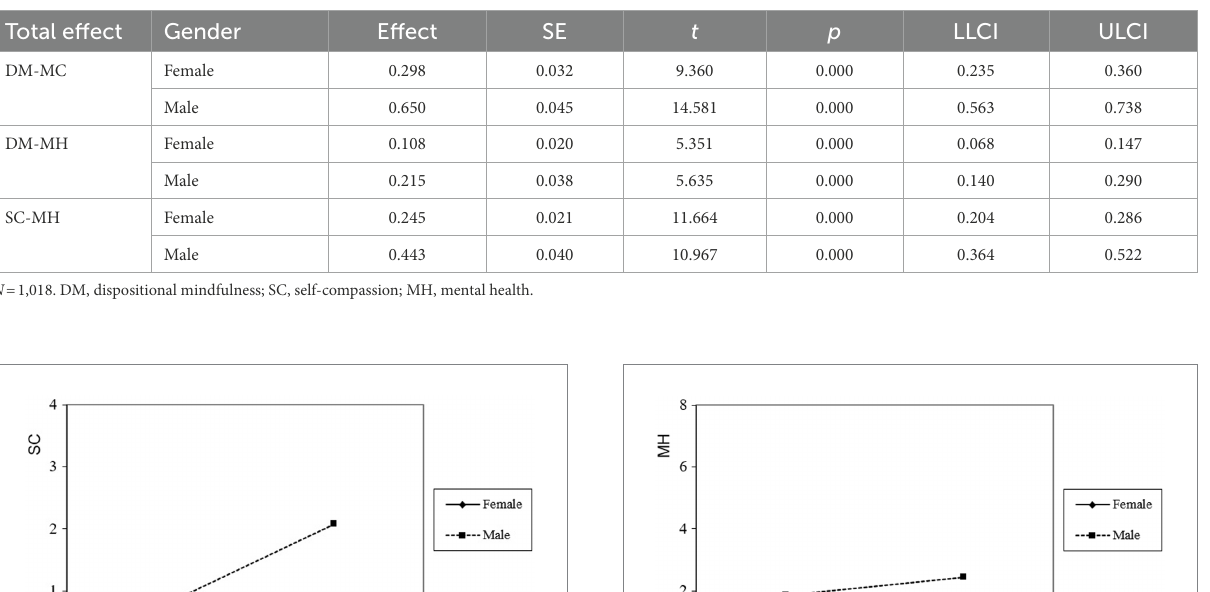
TABLE 6 Effects under different gender conditions.